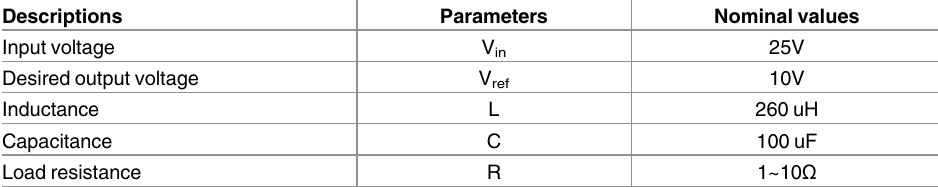
Table 1. Specifications of Buck converter.